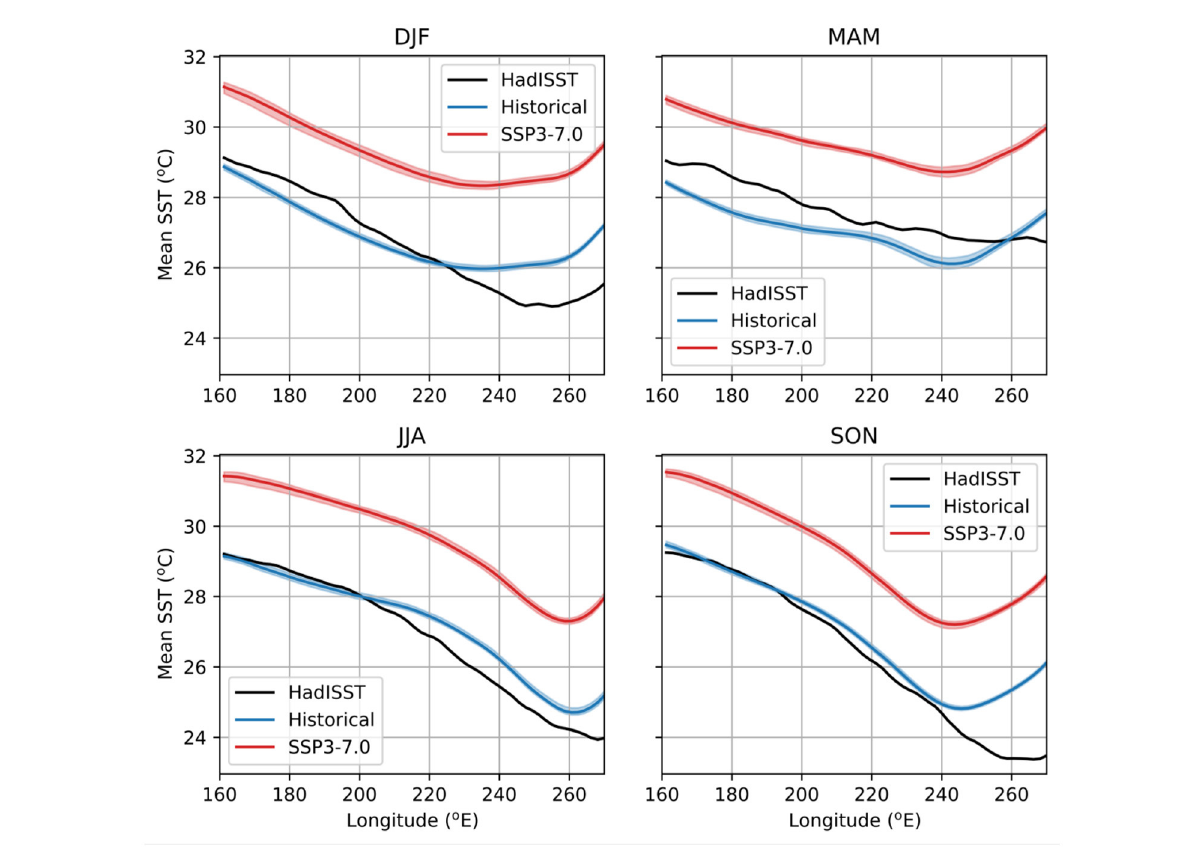
FIGURE1 Seasonal mean equatorial Pacific SSTs ( ◦ C), averaged over 5 ◦ S − 5 ◦ N latitudes, from observations (black curve) and ACCESS-ESM1.5 large ensemble simulations for CMIP6 (colored curves). The time mean SSTs were calculated over 1870–2014 for HadISST and over 1850–2014 and 2015–2100 for the historical and SST3-7.0 experiments, respectively. The ensemble-means (thick blue and red curves) and ensemble spreads (blue and red shades) were estimated from 40 ensemble members of each experiment. The spreads were estimated as the difference between the ensemble maximum and minimum of seasonal mean SSTs at each